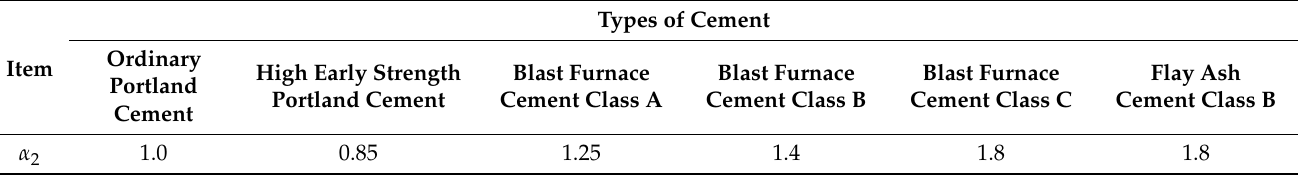
Table 5. Coefficients according to the types of cement.